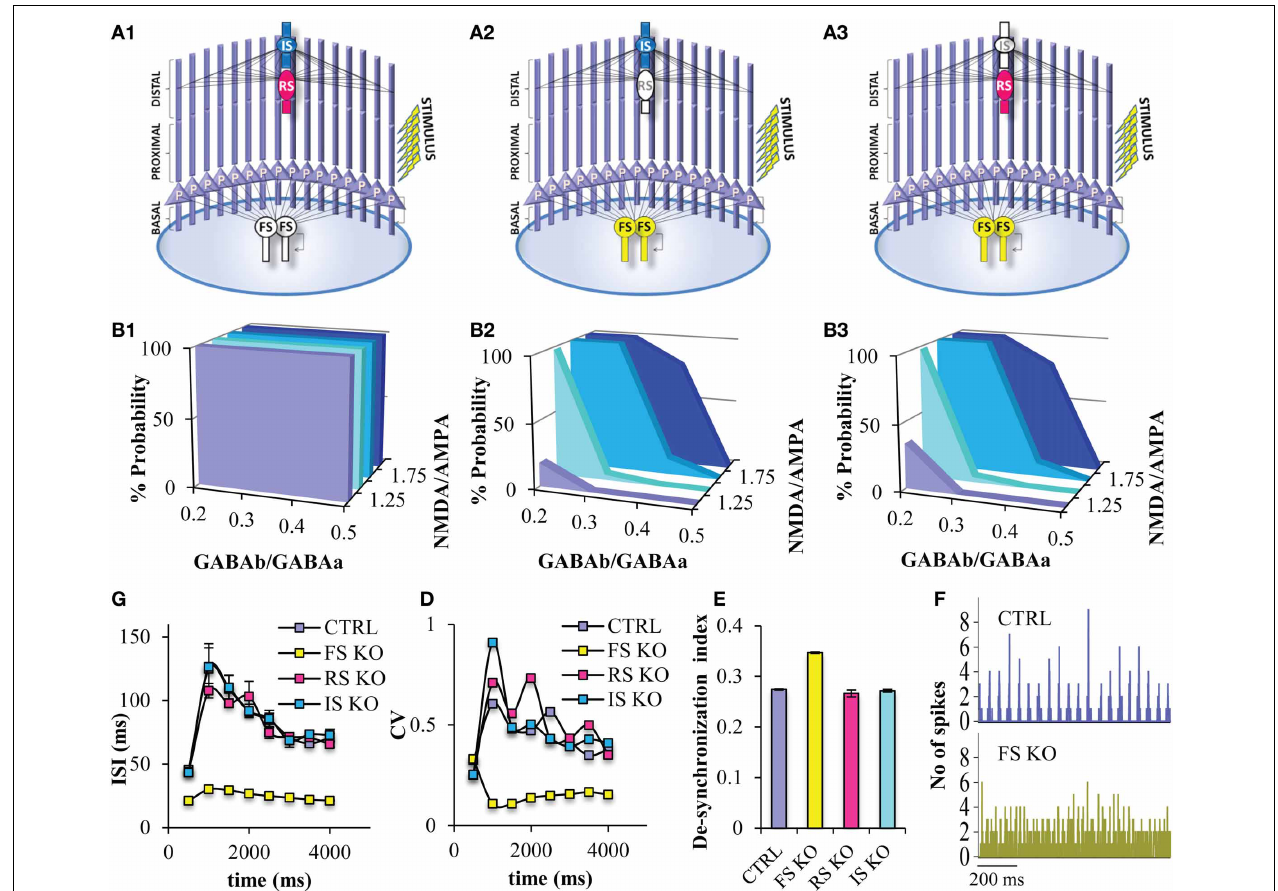
FIGURE 6 | Persistent activity properties at different simulated “interneuron KO” network models. (A) Graphical representations of the FS interneuron KO network model (A1) , the RS interneuron KO network model (A2) , the IS interneuron KO network model (A3) . (B) Graphs showing persistent activity induction across different NMDA-to-AMPA and GABA B -to-GABA A ratios in the FS interneuron KO network model (B1) , the RS interneuron KO network model (B2) , the IS interneuron KO network model (B3) . (C) Graph showing the ISIs before and during